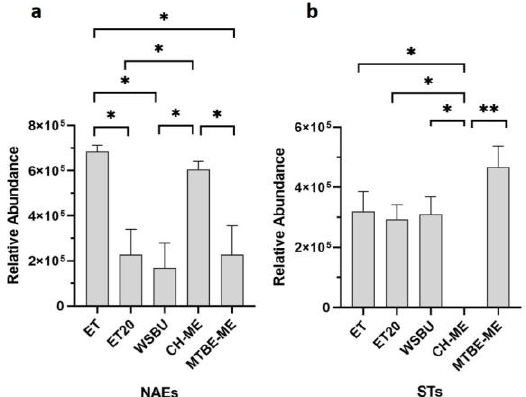
Figure 9. Relative abundance of NAEs ( a ) and STs ( b ) in different extraction methods (mean ± SD of two replicates, * = p -value < 0.05, ** = p -value < 0.01).